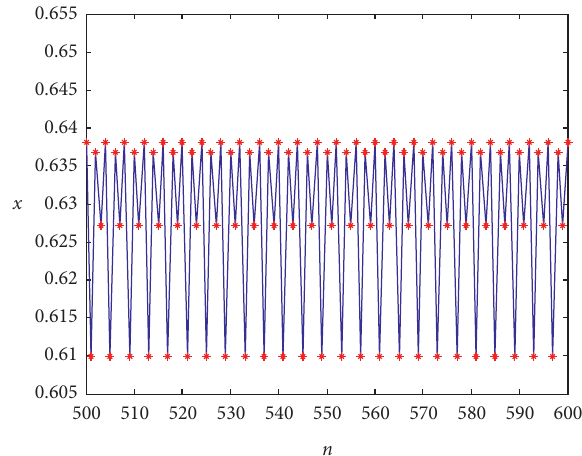
Figure 18: y - z phase diagram which denotes that the system is chaotic when β � 3.